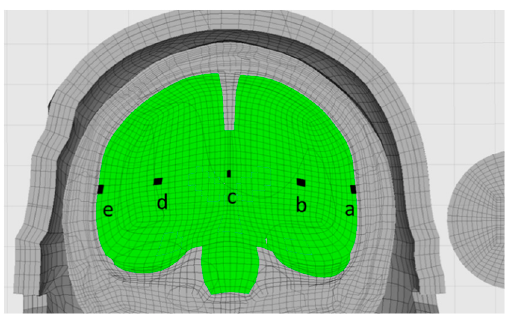
Figure 5. Five elements where the brain pressure responses were